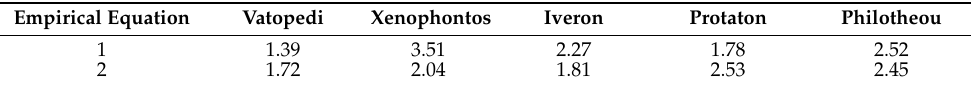
Table 4. Empirical natural frequencies [Hz] of the towers applying empirical models. Empirical Equation